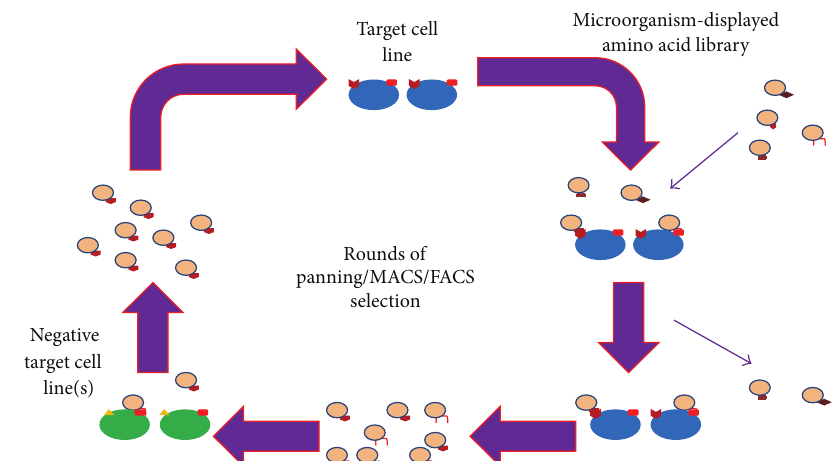
Figure 2: Differential cell SELEX overview. A target cell type is incubated with a na¨ıve amino acid library displayed on the surface of a host. Those that do not bind are removed by various screening methods, commonly panning, MACS, or FACS. Those that do bind are amplified and incubated with negative target cells. Those that do not bind are amplified and resubjected to the target cell line. This iterative screening process continues for multiple rounds under increasingly stringent conditions until one or a few strongly binding MREs are obtained. Figure adapted from [75].